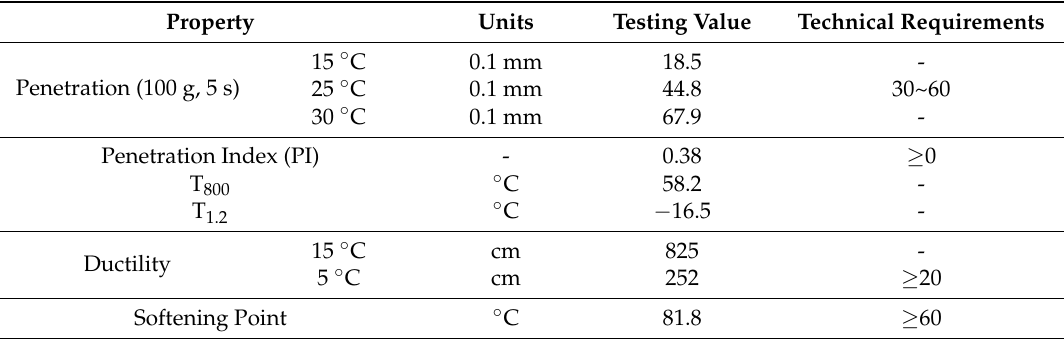
Table 1. Properties of styrene-butadiene-styrene (SBS) modified asphalt binder.